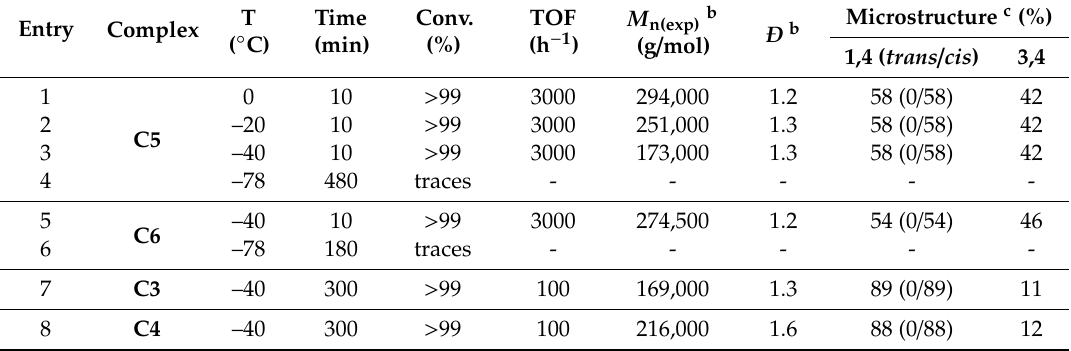
Table 4. Polymerization of isoprene at lower temperatures with pre-catalysts C3 – C6 a